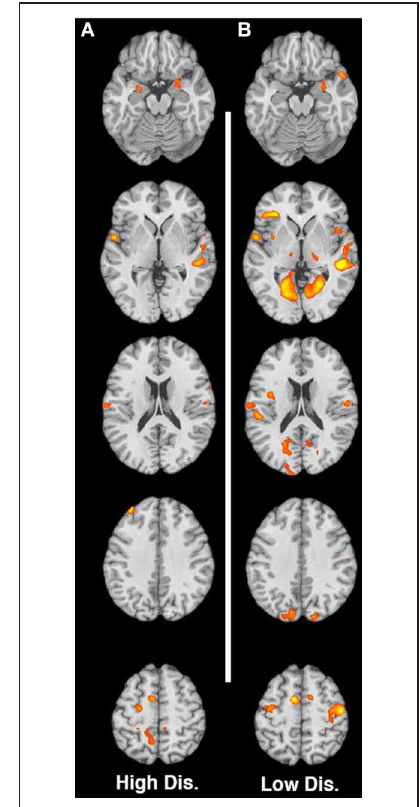
FIGURE 1 | (A–C) Contrast of non-using > substance-using mothers for happy, sad, and neutral faces, respectively. Images are shown in neurological convention, with the left hemisphere on the left side of each image. Slices are at MNI z-coordinate locations − 19, − 1, + 17, + 35, and + 53mm.